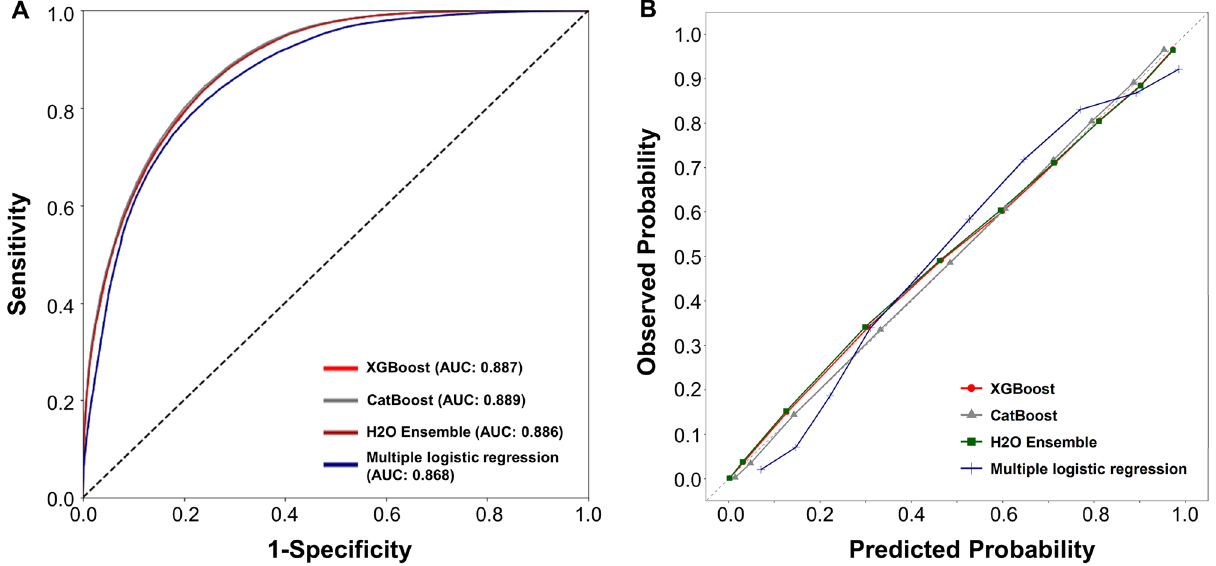
Figure 5. Discrimination statistics ( A ) and calibration plots ( B ) for multivariable logistic regression model and the parsimonious machine learning models in the testing dataset.